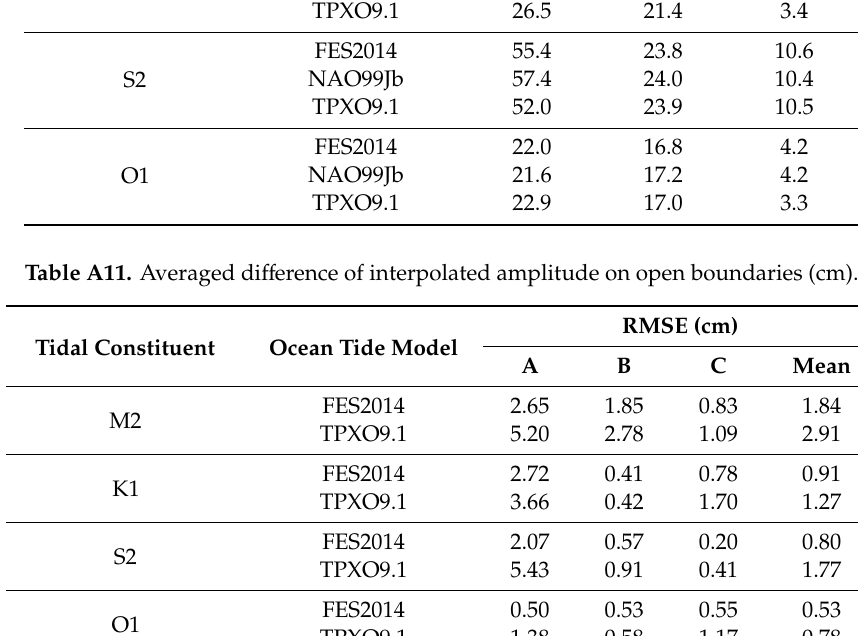
Table A12. D a per 1cm increase of o ff shore tidal amplitude on boundary B. Tidal Constituent